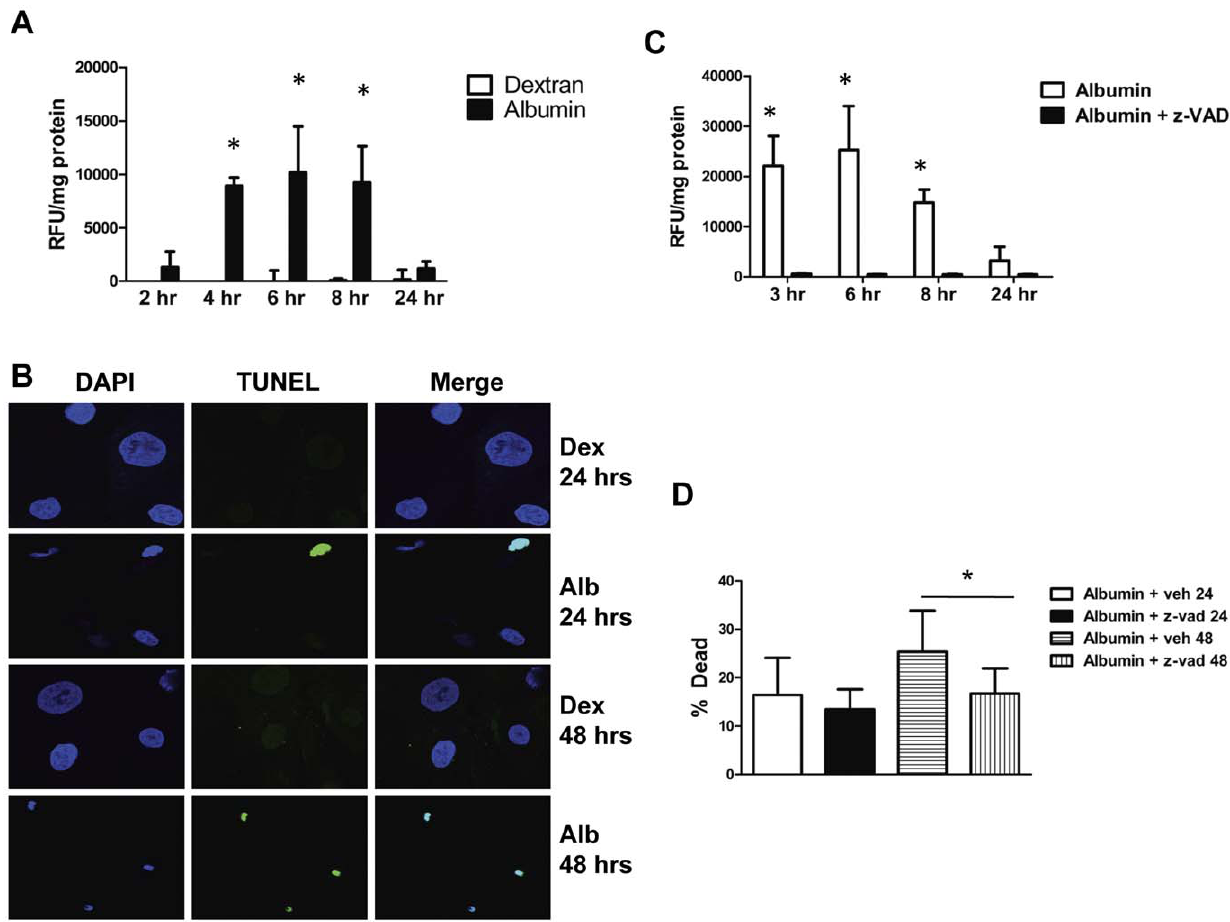
Figure 3. Albumin exposure upregulates pro-apoptotic pathways in podocytes. A , Activated caspase 3/7 activity normalized to total cellular protein in podocytes treated with 5 mg/ml albumin (closed bars) or 5 mg/ml dextran (open bars) as an oncotic control for the indicated amounts of time. * denotes P , 0.0001 compared to corresponding dextran treated control. B , TUNEL staining of cultured podocytes treated with 5 mg/ml dextran (Dex) or 5 mg/ml albumin (Alb). Nuclei are stained blue with DAPI. TUNEL-positive nuclei are green. C, Caspase 3/7 activity normalized to total cellular protein in podocytes treated with 5 mg/ml albumin or 5 mg/ml albumin + 50 m M z-VAD, a pan-caspase inhibitor. z-VAD largely abrogated caspase activity (*, P=0.01 versus albumin + z-VAD). D , Percentage of dead cells measured using the trypan blue assay in podocytes treated with 5 mg/ml albumin alone (open bar) or 5 mg/ml albumin + 50 m M z-VAD (closed bar) for 24 hrs or 5 mg/ml albumin alone (horizontal hatched bar) or 5 mg/ml albumin + 50 m M z-VAD for 48 hrs (vertical hatched bar). * denotes P=0.001 compared to albumin + z-VAD at 48